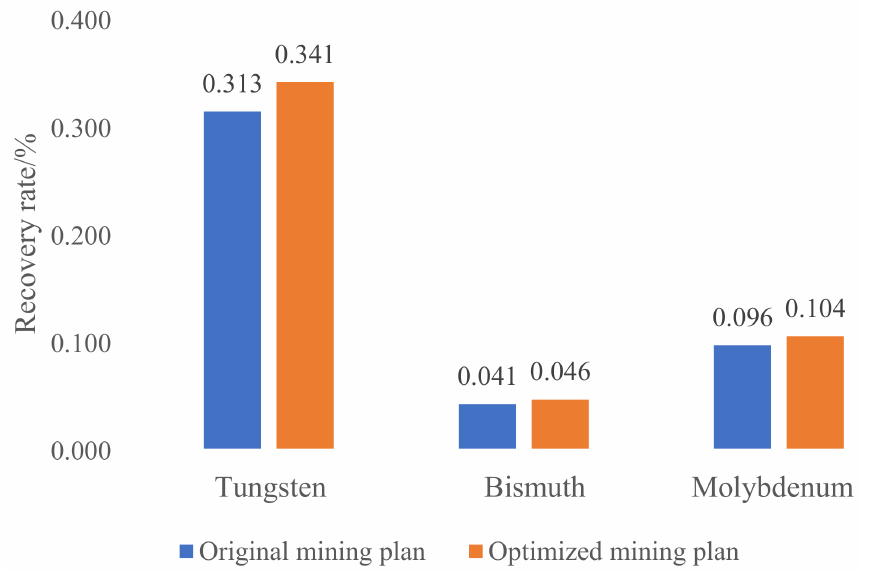
Figure 5. Comparison of recovery rates of three